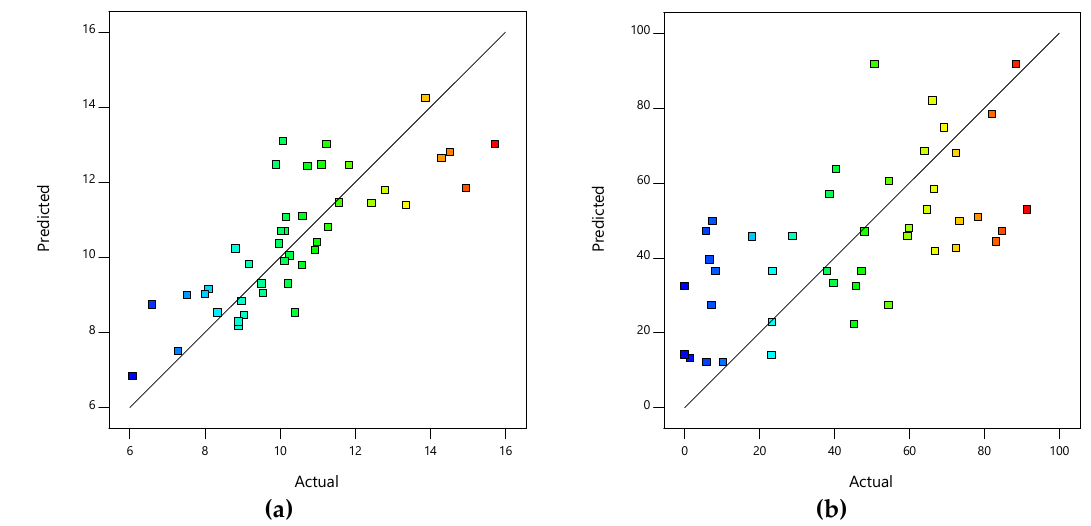
Figure 6. Predicted particle sizes in comparison to the actual particle sizes (a) . Predicted magnetite content in comparison to the actual magnetite content (b) .